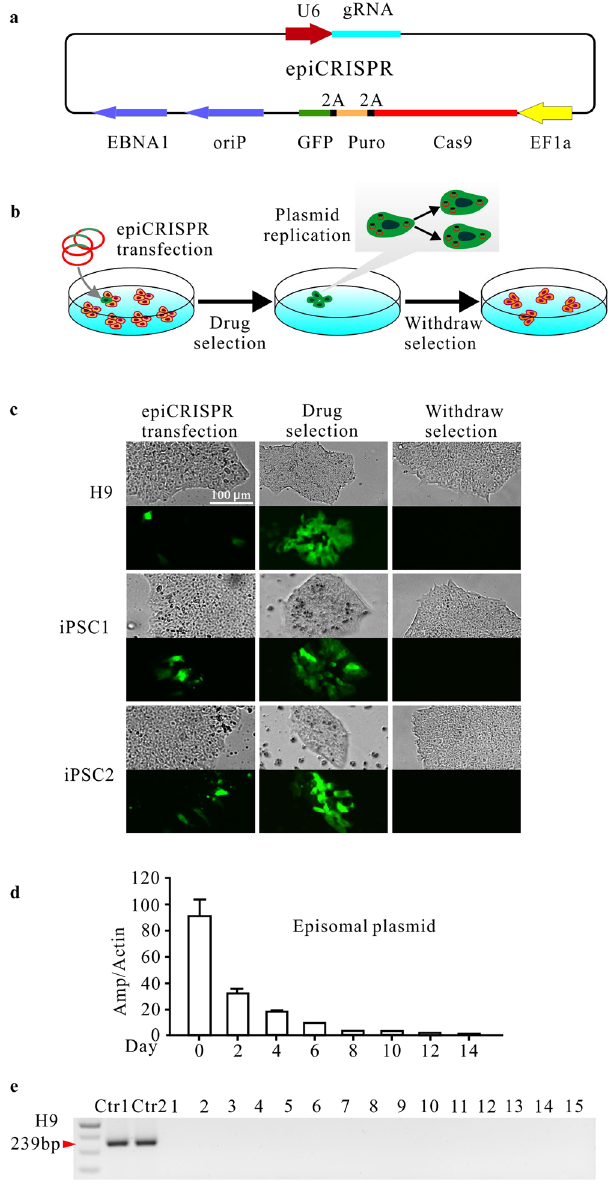
Figure 1. An epiCRISPR system for exogenous gene-free genome editing in hPSCs. ( a ) Schematic of the epiCRISPR system design. The vector contains a U6 promoter-driven gRNA scaffold, an EF1a promoter- driven Cas9 fused to puromycin resistance gene and GFP with P2A peptides, and OriP/EBNA1 elements for the plasmid replication in eukaryocytes. Puro, Puromycin resistance gene. ( b ) Schematic of genome editing with epiCRISPR system. The epiCRISPR vector is transfected into hPSCs followed by drug selection. Only the transfected cells can survive and proliferate. The epiCRISPR vector can replicate in hPSCs and can be partitioned to daughter cells . In the absence of drug selection, the epiCRISPR vector can be lost, allowing edited cells free of exogenous gene expression. ( c ) The epiCRISPR system for stable gene expression in hPSCs. The left panel shows the epiCRISPR vector delivered into hPSCs with lipid-mediated transfection. The middle panel shows the epiCRISPR vector can replicate during hPSC proliferation under drug selection. The right panel shows the single cell-derived clones lost epiCRISPR vector without drug selection. ( d ) Episomal vector was decreased within cells over time after withdrawing puromycin selection. The plasmid was tested every two days by quantitative PCR (n = 3, error bars show mean ± S.D.). ( e ) The absence of episomal vector in single cell- derived hESC clones was confirmed by PCR targeting ampicillin sequence. Ctr1 is the positive control amplified from the epiCRISPR plasmid DNA; Ctr2 is the positive control amplified from the pooled hESCs containing epiCRISPR